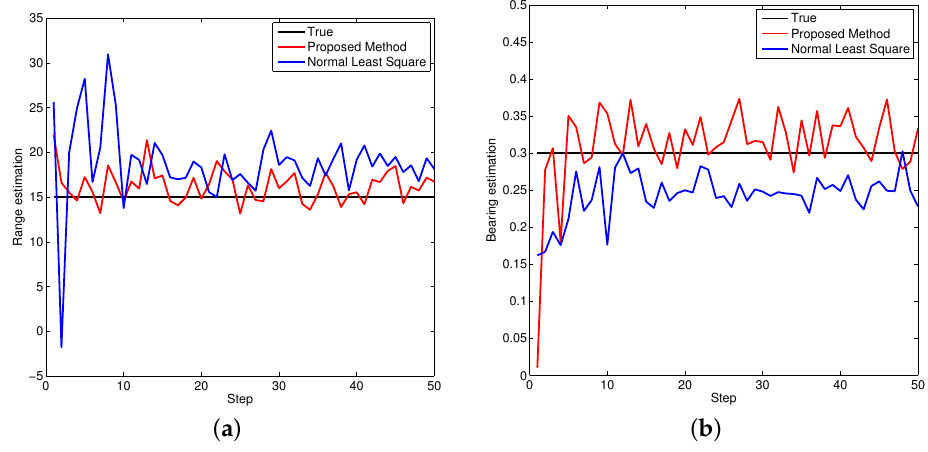
Figure 5. Bias estimations for object one. ( a ) Bias estimation in range; ( b ) Bias estimation in